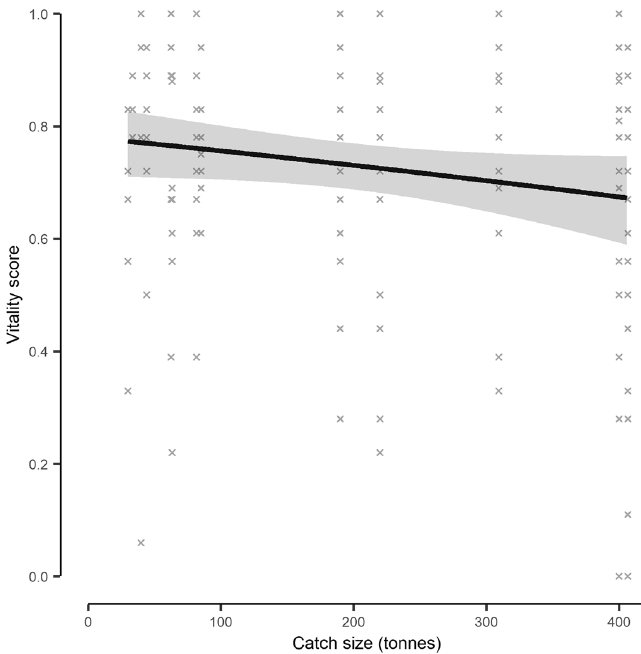
Figure 4. The model derived relationship between Atlantic mackerel ( Scomber scombrus ) vitality scores and catch size during crowding events onboard a commercial purse seine vessel. Fish were collected throughout crowding (after being pumped onboard) and assessed for behavioural vitality. The shaded area indicates the model derived 95% confidence interval, with the underlying data indicated as crosses.